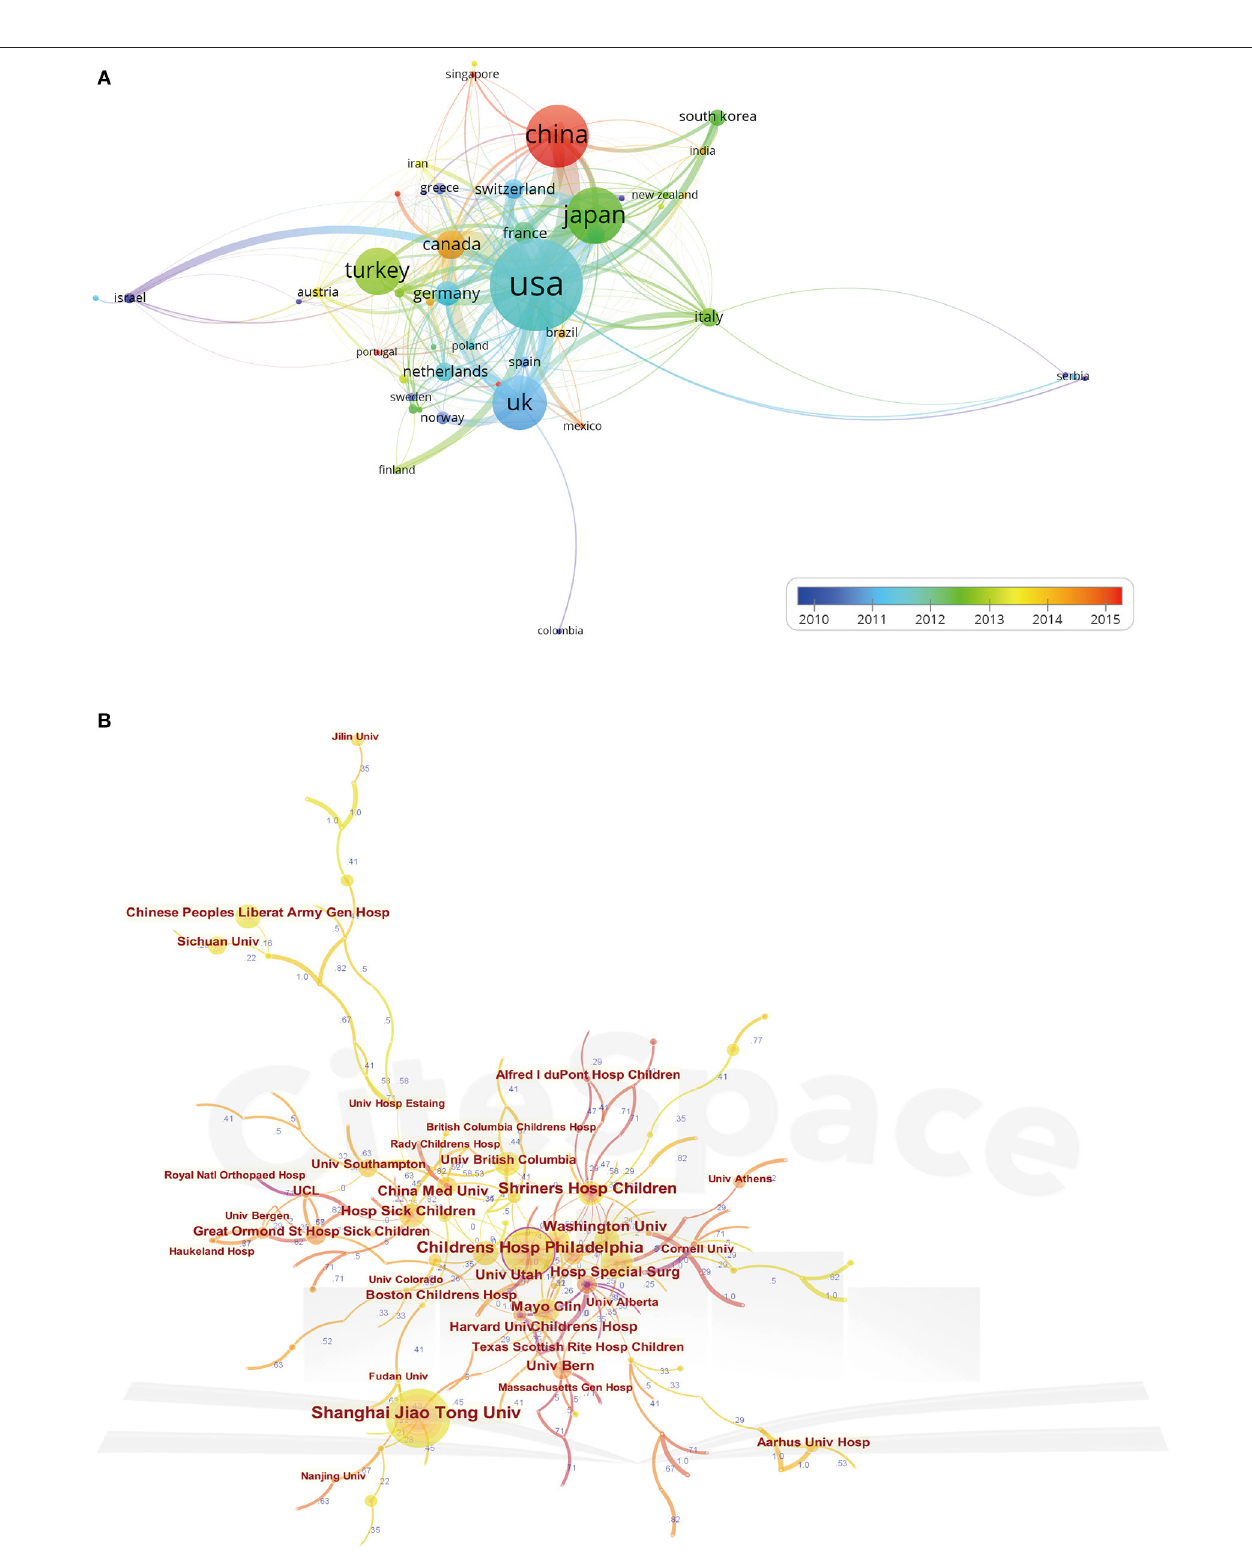
FIGURE 4 | (A) The co-authorship map of countries/regions involved in DDH research (generated by VOSviewer). Each node represents a different country, and the node size is proportionate to the number of publications. Different nodes were coded with different colors, depending on the average appearing year (AAY) of the country. Specific division information can be seen in the color gradient at the bottom right. (B) The cooperation network map of institutions involved in DDH research (generated by CiteSpace). The nodes with a high BC-value ( ≥ 0.1) are indicated by purple rings.